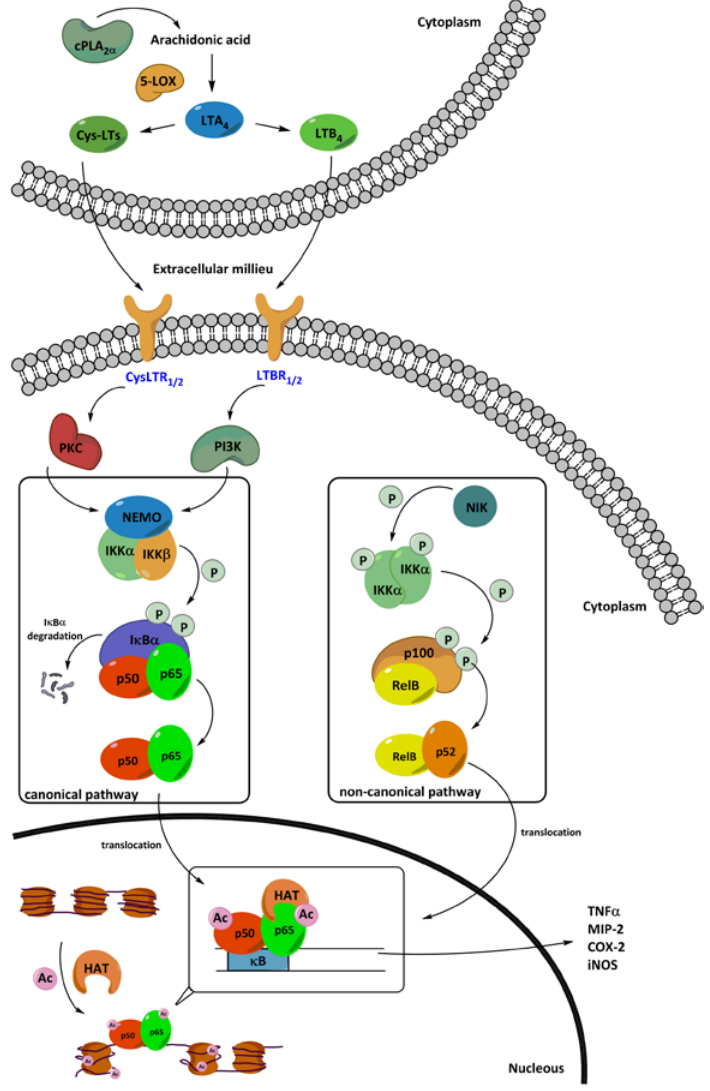
Figure 1. The roles of leukotrienes and acetylation in the expression of pro-inflammatory mediators through the NF- κB pathway. The activated cPLA2α produces arachidonic acid, which is further converted to LTA4 by the 5-LOX. LTA4 is then converted to LTB4 and cys-LTs and their binding to the leukotriene receptors activate the NF- κB pathway in